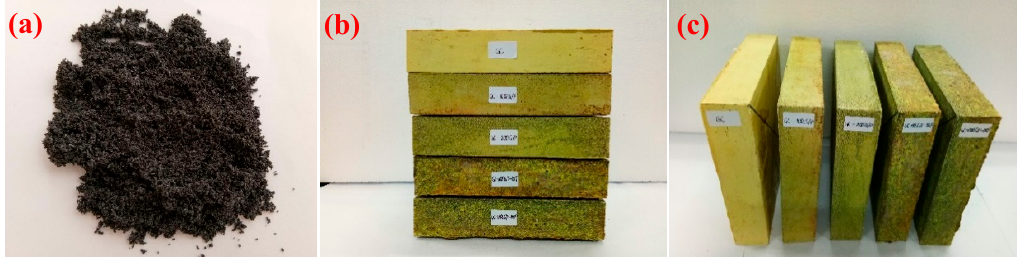
Figure 2. The morphology of the prepared materials: ( a ) Appearance of the prepared EG/P; ( b , c ) prepared gypsum board.